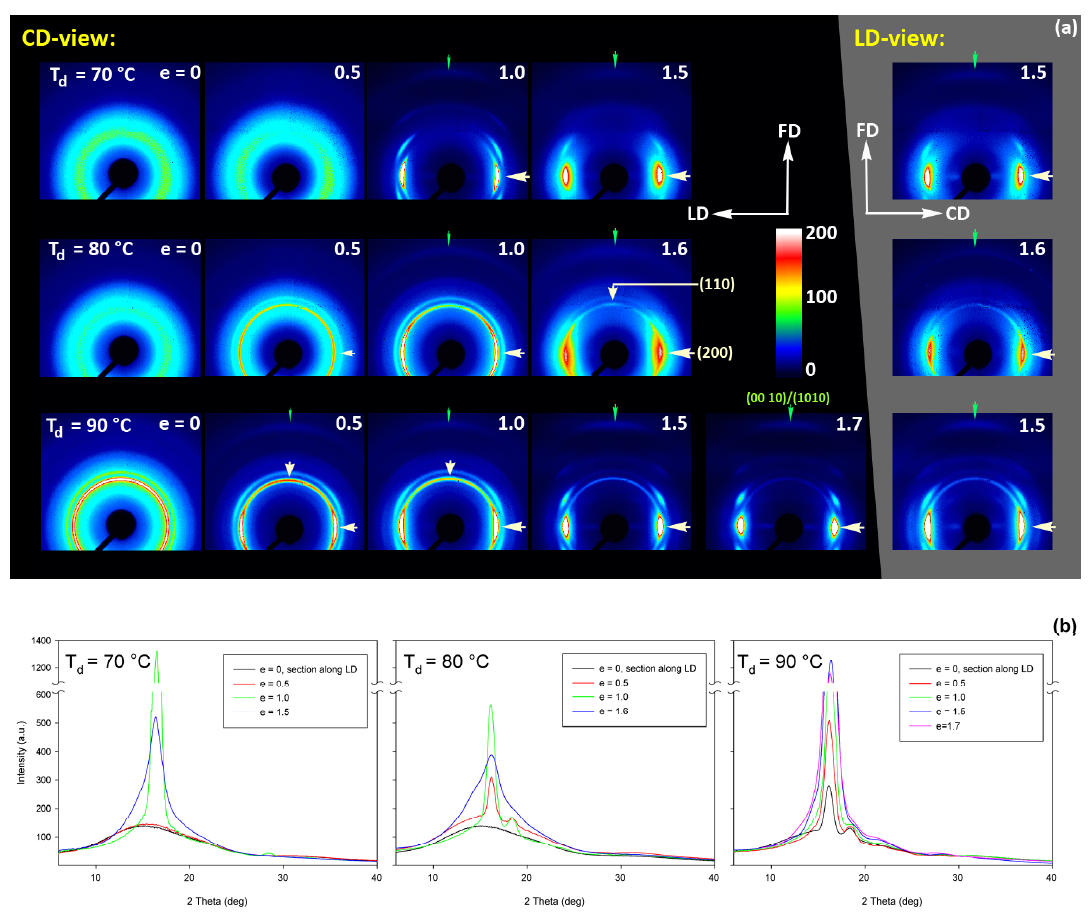
Figure 12. ( a ) Transmission 2D-WAXS patterns of the initially amorphous A samples deformed in the plane-strain com- pression at temperature T d = 70 °C ( top row ), T d = 80 °C ( middle row ), and T d = 90 °C ( bottom row ), to the indicated true strain. The patterns on the left (on a black background) were obtained in the CD-view (X-ray illumination along the CD, image plane perpendicular to it). The column on the right (gray background) shows the patterns collected in the LD-view. The white arrows indicate positions of the maxima in the (200)/(110) reflection, while the green arrows mark the weak maxima related to the (0010) and (1010) reflections. ( b ) One-dimensional radial sections derived from CD-view images along the loading direction, LD—obtained by azimuth integration of 2D pa tt erns in the azimuth range ( − 5°, +5°) around LD ( ψ LD = 0°).